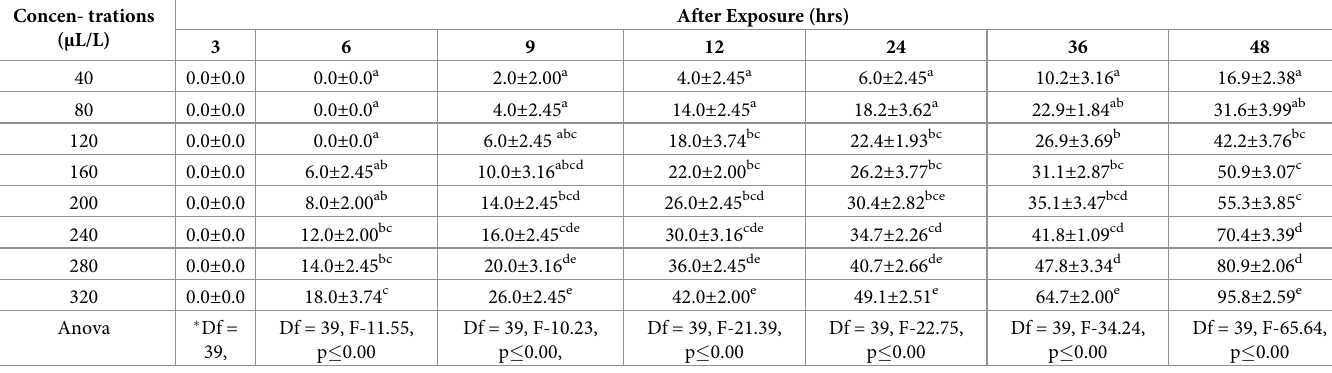
Table 3. Larvicidal activity (%) of essential oil from C . citrinus against T . Castaneum . Concen- trations ( μ